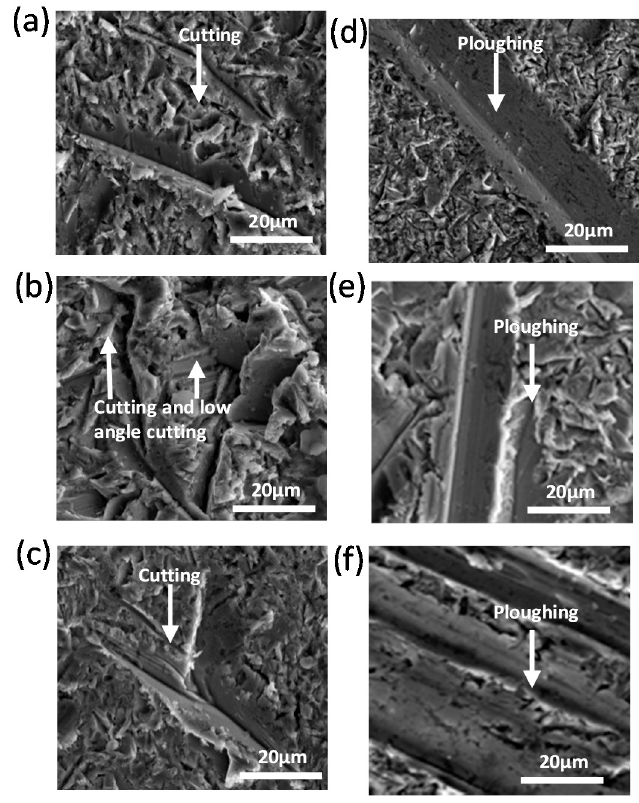
Figure 9. SEM micrographs of 80 m/s at 30° for ( a ) 10 s, ( b ) 300 s, and ( c ) 600 s, and at 90° for ( d ) 10 s, ( e ) 300 s, and ( f ) 600 s.